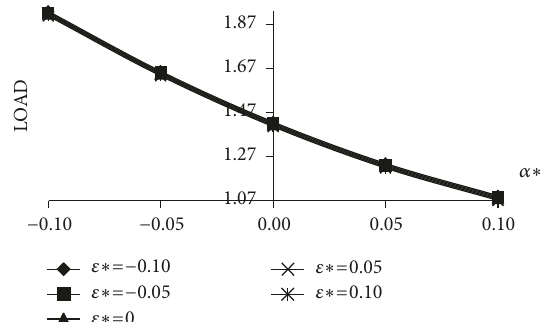
Figure 14: Variationof load carrying capacity with respectto 𝛼 ∗ and 𝜀 ∗ .